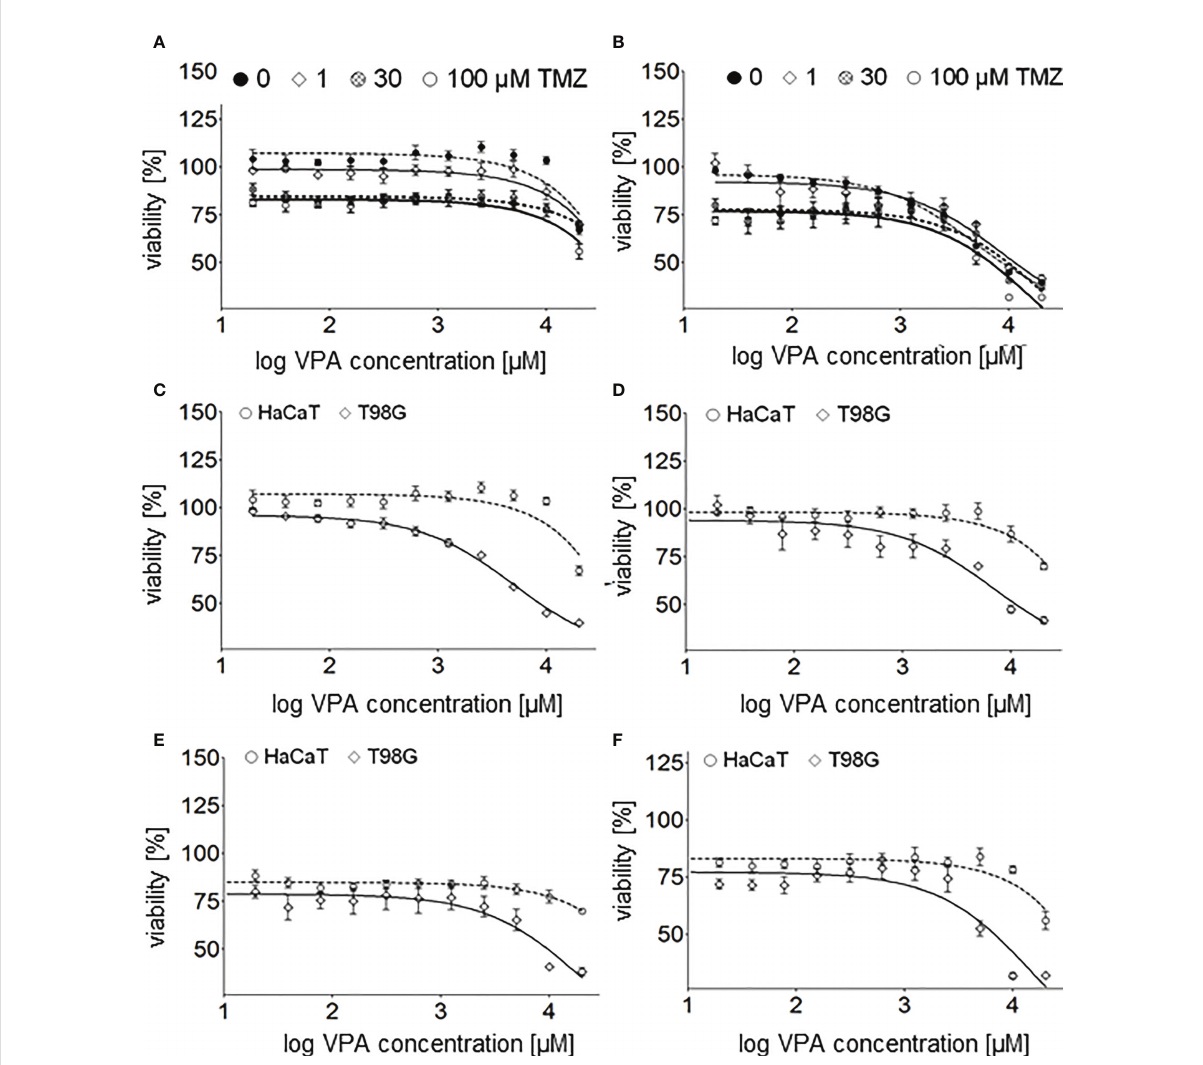
FIGURE 5 Cell viability assay of the glioblastoma cell line T98G – (A) , and the keratinocyte cell line HaCaT – (B) 24 h after cell culture supplementation with both TMZ (0, 1, 30, 100 µM) and different concentrations (20, 39, 78, 156, 313, 625, 1250, 2500, 5000, 10000, 20000 µM) of VPA. Cell viability assay of the glioblastoma cell line T98G and the keratinocyte cell line HaCaT 24 h after cell culture supplementation with different concentrations (20 – 20000 µM, log concentration 1.3 - 4.3 µM) of VPA – (C) and both VPA and 1 µM – (D) , 30 µM – (E) and 100 µM - (F) of TMZ. Values are means ± SE of at least four